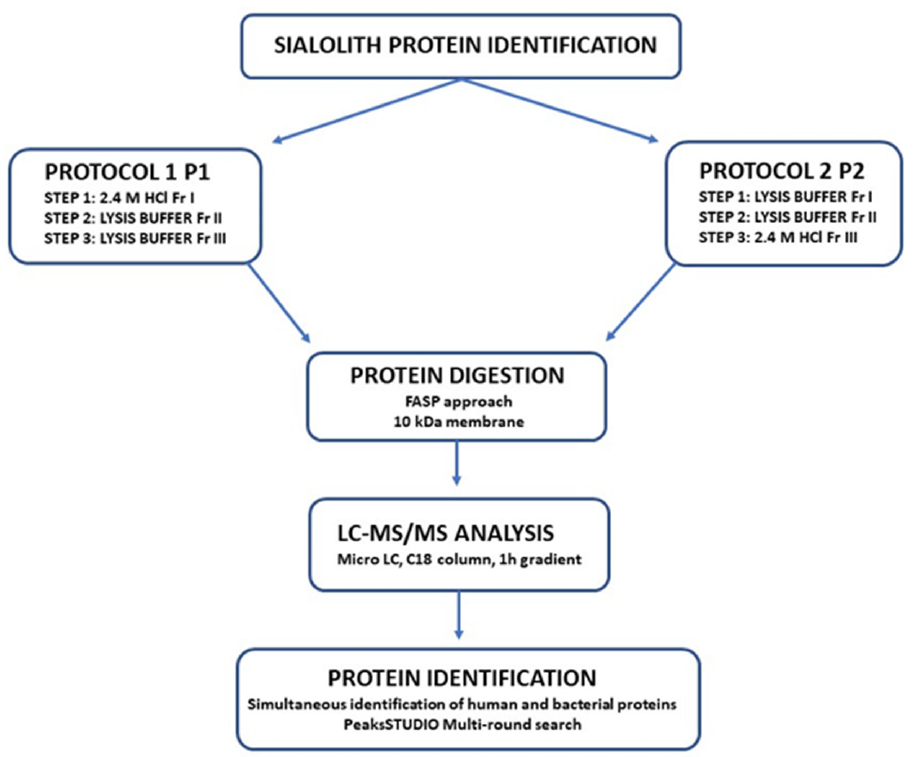
Figure 2. The diagram represents the methods used to identify sialolith constituent proteins. Protein digestion for each of the received fractions separately was performed according to the standards of the FASP procedure. After heating the proteins in the lysis buffer and cooling the solution, protein concentration was measured, and in each case, 100 µ g of proteins was taken from the tested fraction and placed on a 10 kDa membrane. The trypsin digestion was performed overnight in a 37 ◦ C constant temperature incubator. After digestion, 10 µ g of peptides from each fraction was subjected to final StageTips purification with C18 phase. After LC-MS/MS analysis according to the parameters described in the Materials and Methods chapter, the obtained data were analysed in the PEAKS Studio program. First, the data were analysed against the Homo sapiens database, and then in Multi-Round Search were analysed against the entire bacterial database. In this way, identifications were performed for each of the fractions obtained in the protein extraction process. Detailed results of the analysis for sample S1 are presented in Supplementary Table S1 in the manuscript